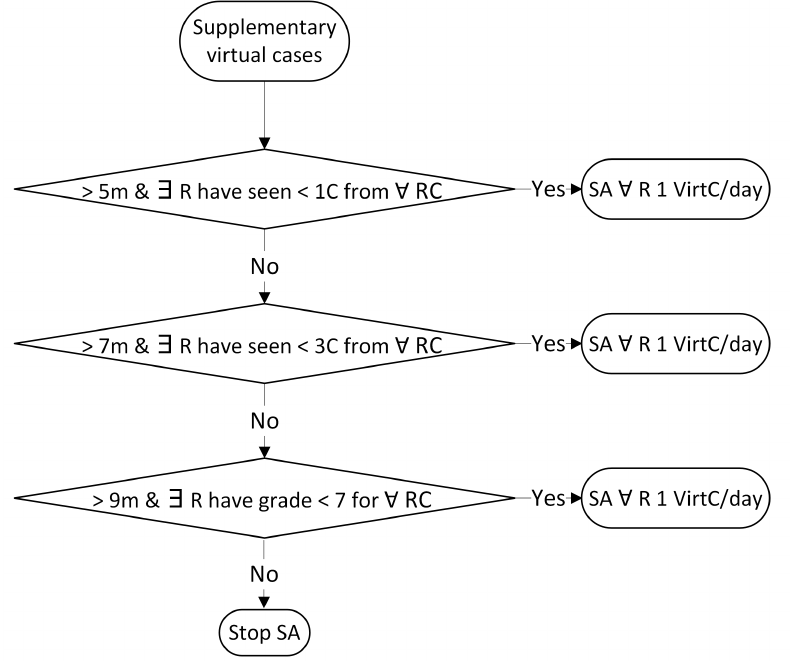
Figure A3. Rules for assigning supplementary virtual cases (C = case; m = months; R = resident; RCs = retinal conditions; SA = supplementary assign; VirtC = virtual